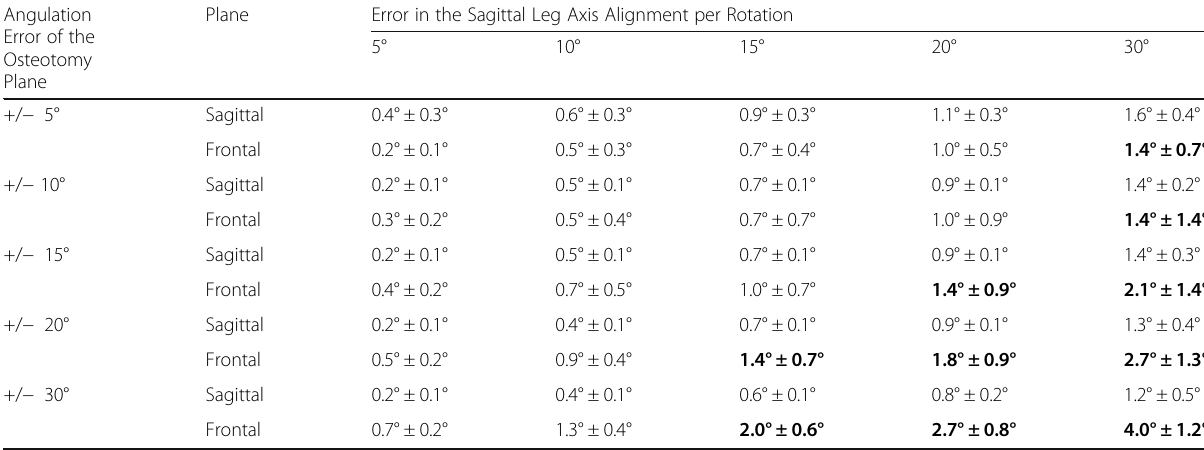
Deviations greater than 2° (mean value plus standard deviation) have been marked